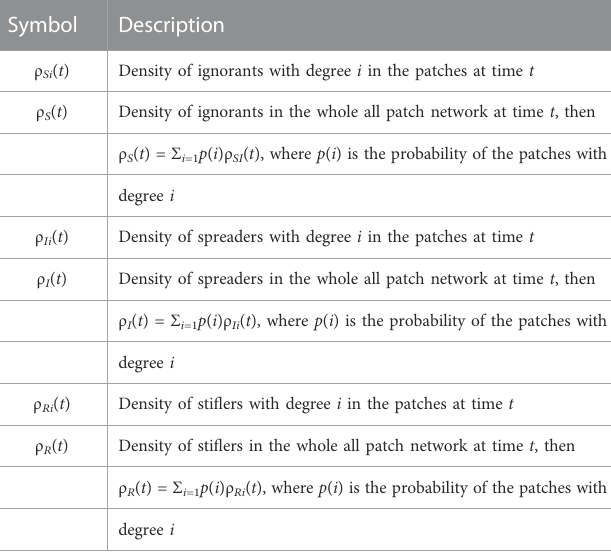
TABLE 1 Description of symbols. Symbol